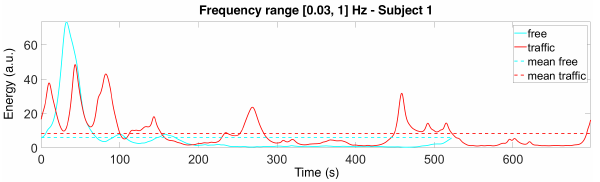
Figure 5. Signals obtained as a sum of the squared absolute values of the CWT coefficients in the selected frequency range for Subject 1 (in both scenarios).